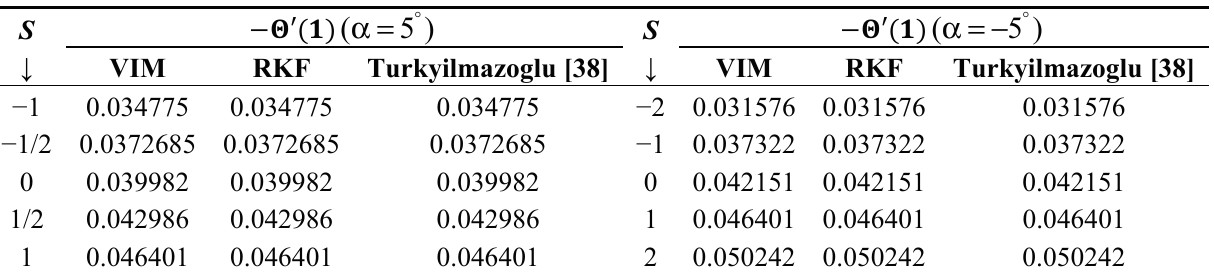
Table 3. Comparison of the numerical values for the Nusselt number with the already existing solutions in the literature for